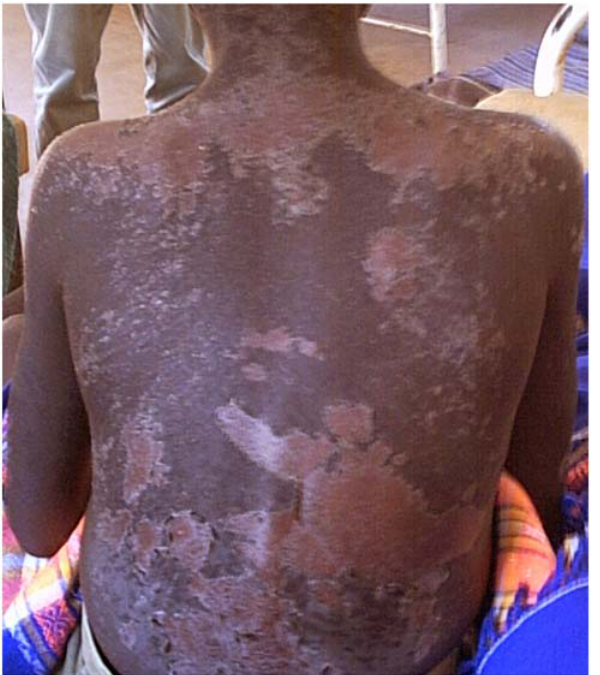
Figure 2. Child with Resolved Exfoliative Dermatitis (Epidermal Necrolysis) Resulting from Early Stage T.b. rhodesiense HAT Treatment with Suramin. The acute stage of this condition presents with blistering and the peeling off of large areas of skin; complications due to secondary infection are likely. Image credit: Eric Fe`vre.